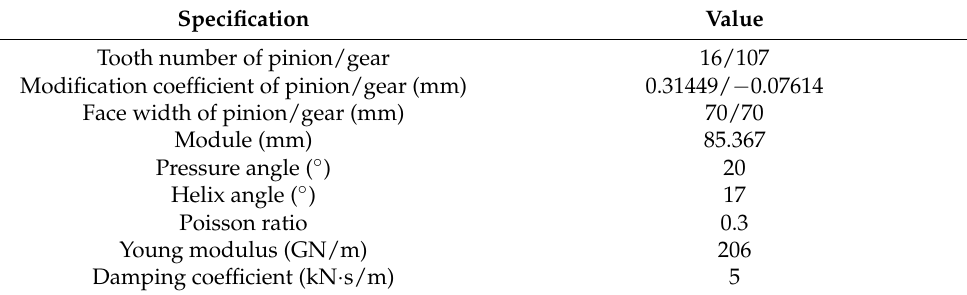
Table 2. Main parameters of gear model.